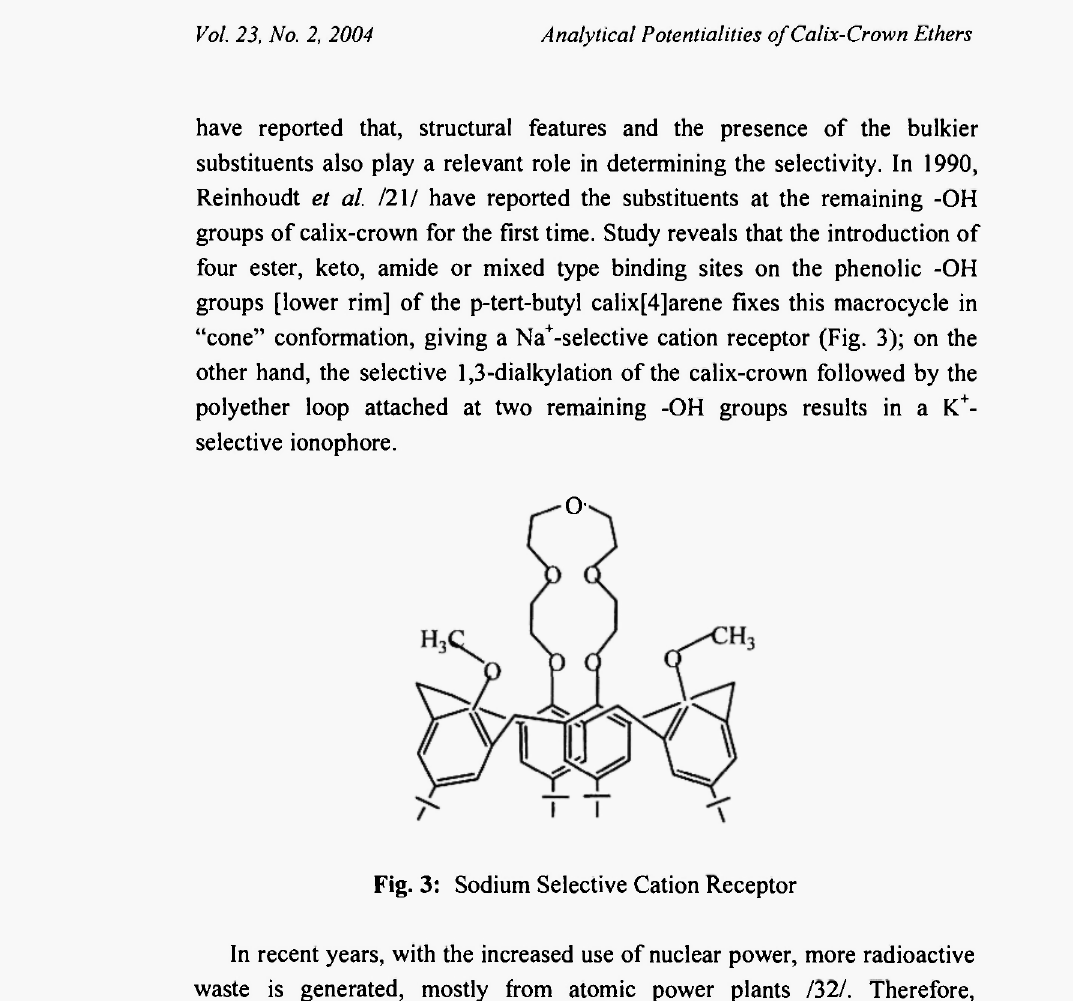
Fig. 3: Sodium Selective Cation